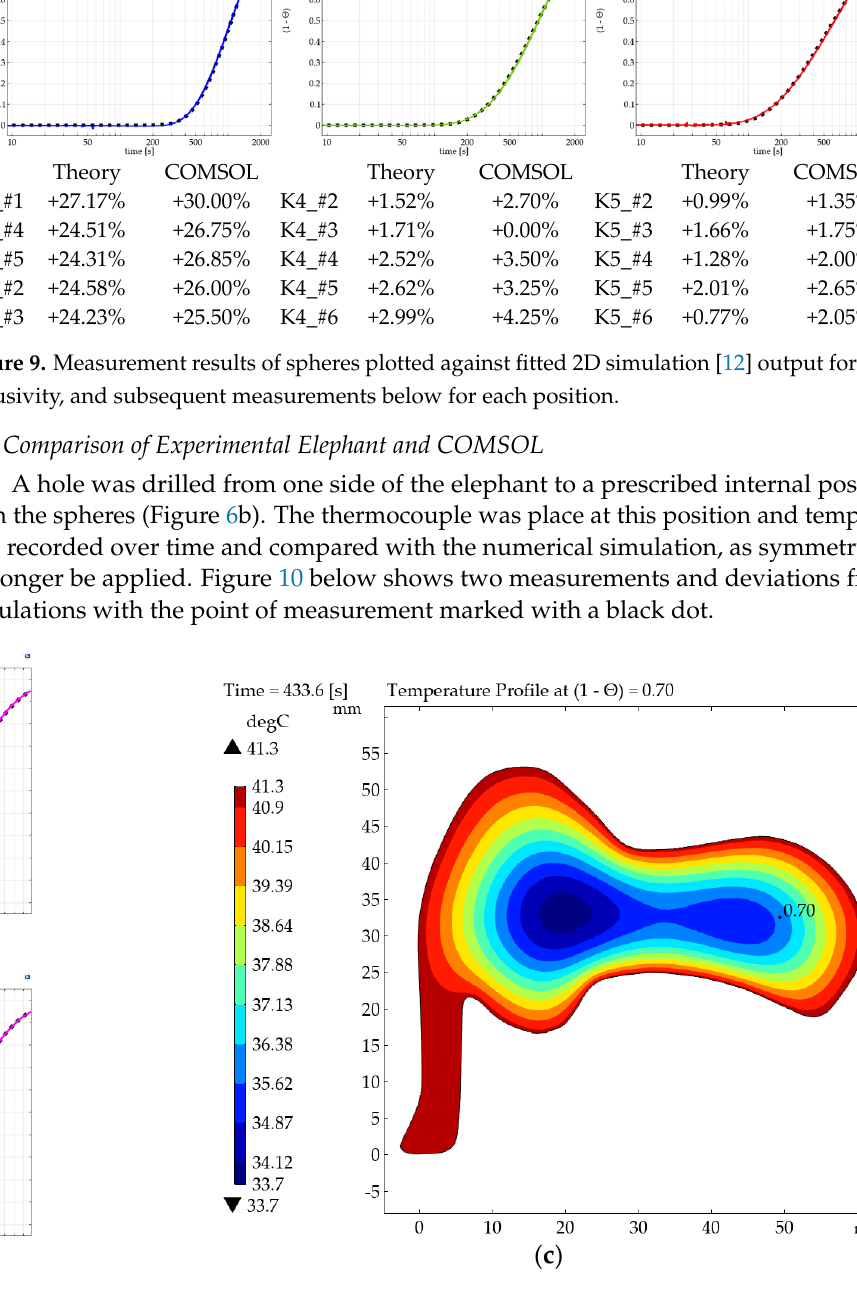
( c ) Figure 11. Comparison of numerical results [12] for ( a ) r = 0 mm; ( b ) r = 14.8 mm; and ( c ) r = 19.3 mm with the analytical approximation [10,11]. 4.2. Comparison of Experimental Sphere Measurements, Theory, and COMSOL The accuracy of measurements varied with the position within the sphere. The center (r = 0 mm) measurements proved to be the worst performers. Figure 9 shows relatively large deviations from the theory and model and is an expected result. The center of an object with spherical symmetry is equally affected in space and time by imperfect placing of its tip. The asymmetric nature of the fluid flow, measurement equipment, and the hole drilled into a sphere disrupt the boundary condition of a uniform heat transfer rate at the surface. Thus, the measurements render a poor comparison with model results as the model did not incorporate any asymmetric features. For the off-center positions (r = 14.8, 19.3 mm), the results were in good agreement with the model. These two measurement positions were located closer to the direction of